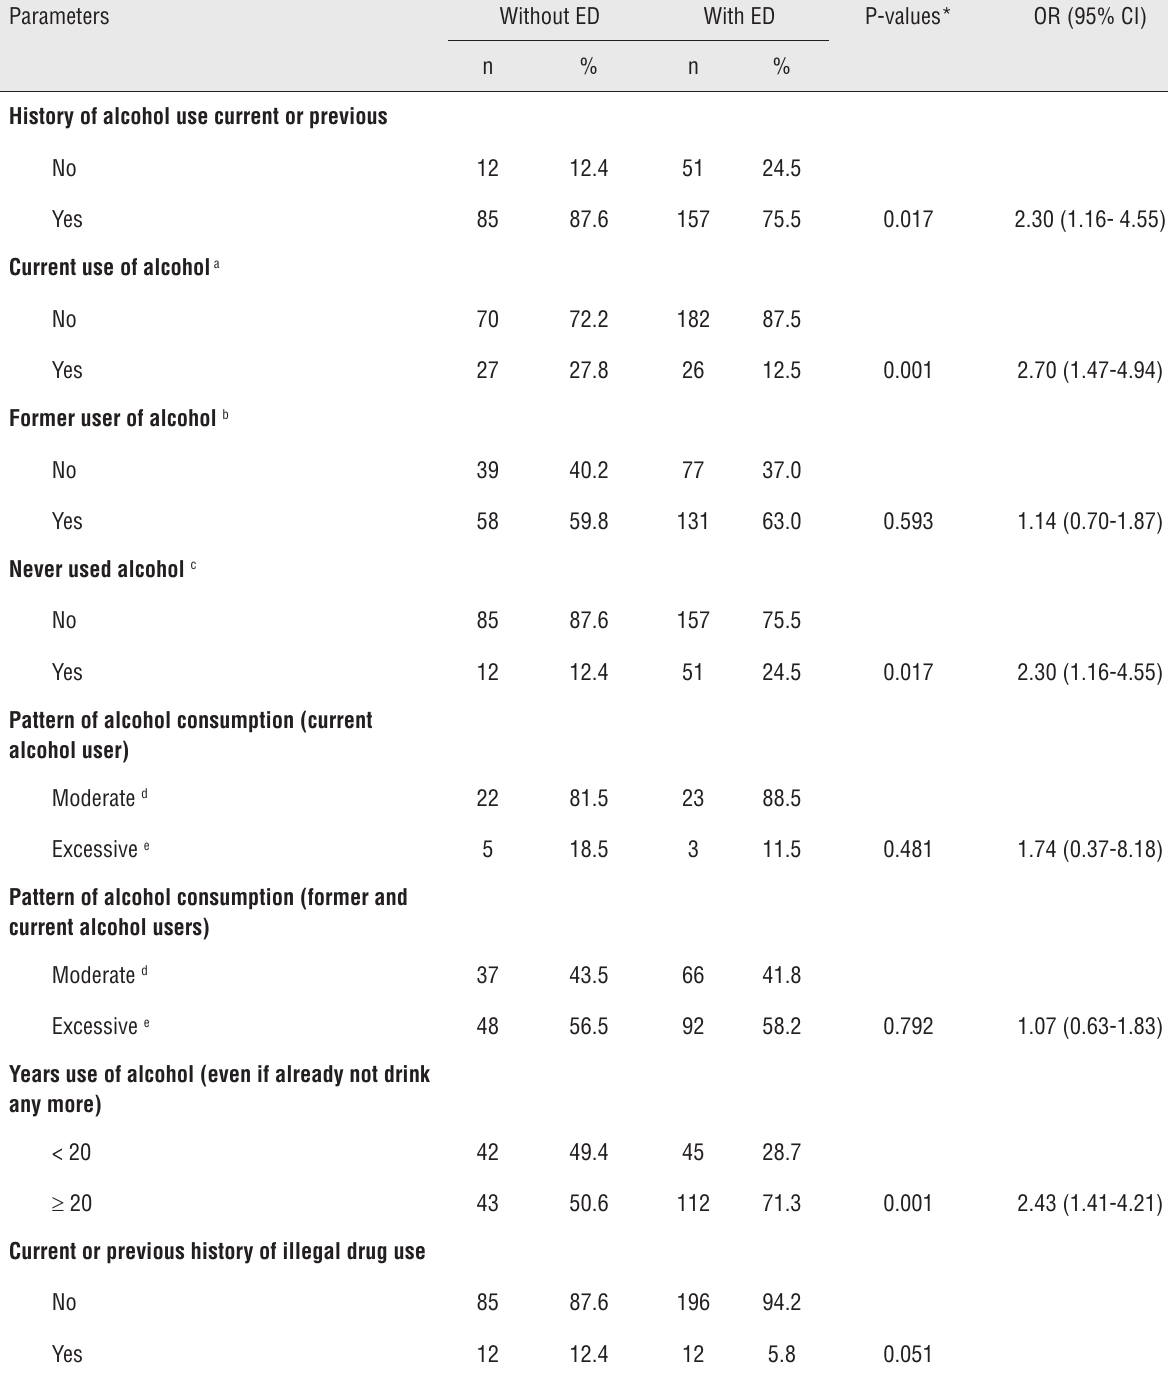
Table 3 - Association of habit of use of alcohol and drugs with Erectile Dysfunction in hemodialysis patients. Parameters Without ED With ED P-values* OR (95% CI) n % n